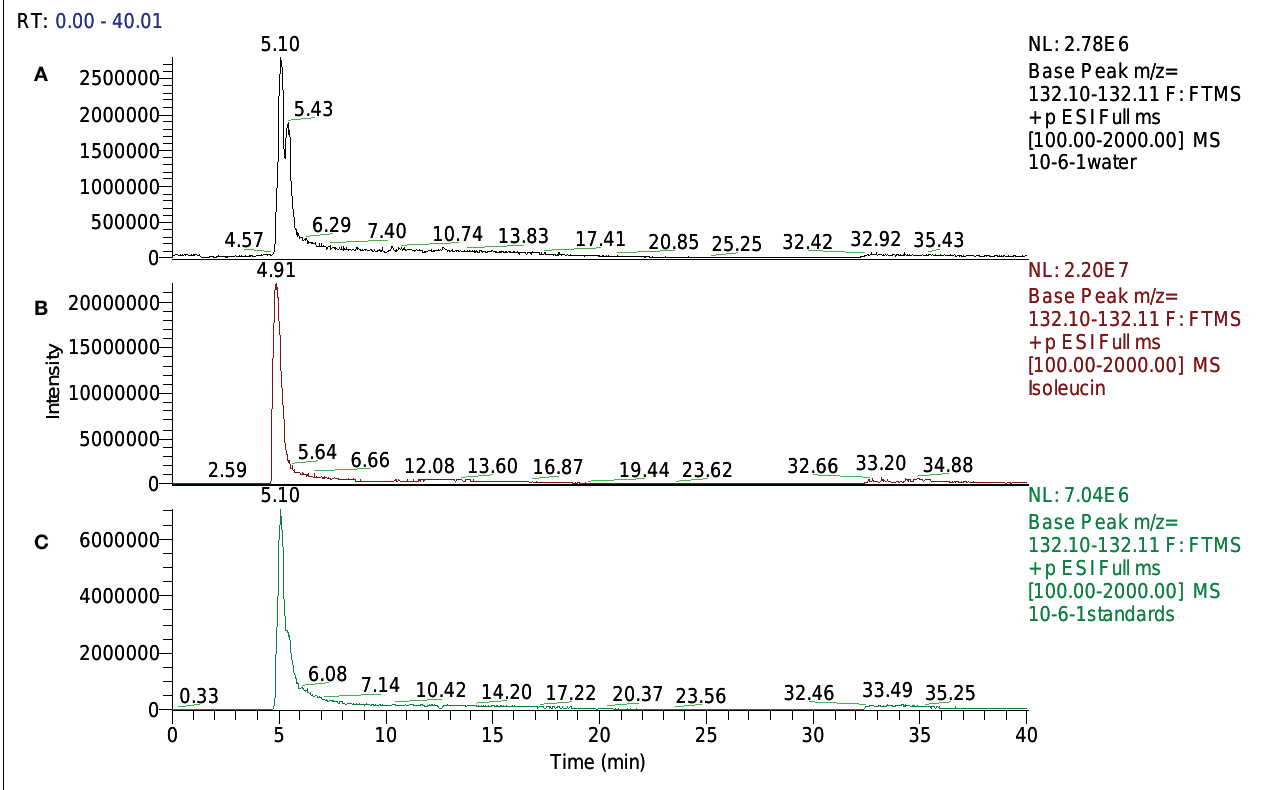
FIGUREA13 | RP-HPLC–ESI-MS (Orbitrap) base peak chromatograms of (A) isoleucine showing the m / z range 132.10–132.11, (B) an unspiked xylem sap sample, showing the m / z range 132.10–132.11, and (C) a xylem sap sample spiked with isoleucine, showing the m / z range